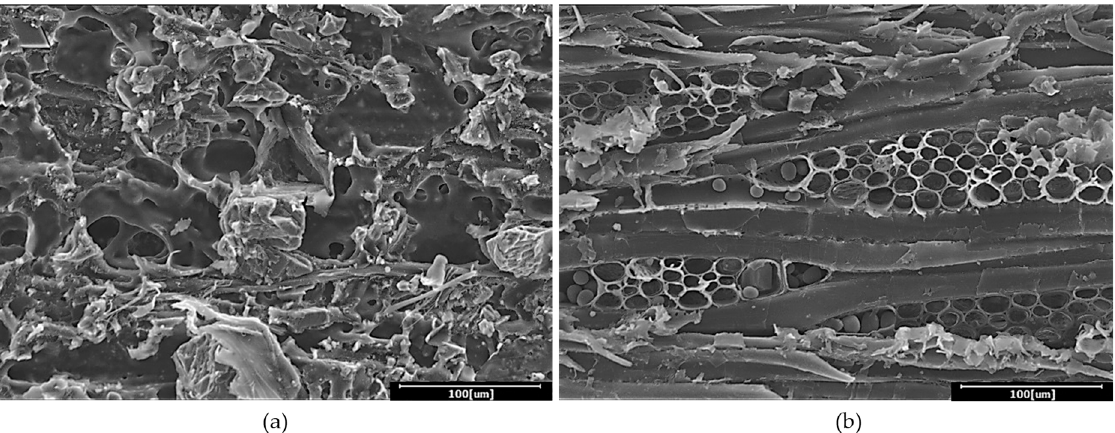
Figure 6. Veneer surface from delamination test observed using SEM with 500× magnification; ( a ) glueline failure and ( b ) wood failure.